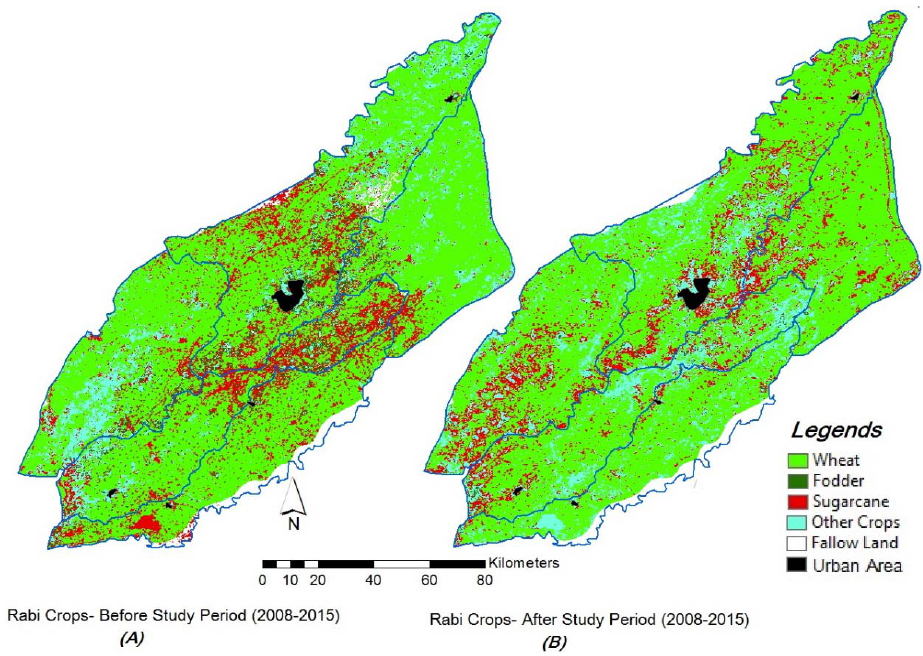
Figure 3. Land use change in the Rabi Crops ( A —before study period, B —after study period).